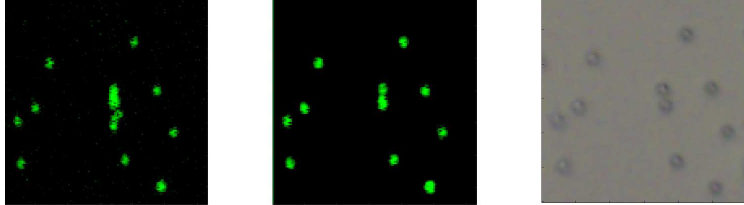
Figure 6. Imaging of the cross-section with 2 µ m microspheres only: ( Left ) SOCT image of the cross-section obtained by short-time Fourier transform method; ( Middle ) SOCT image of the cross-section obtained by the proposed method; and ( Right ) cross-sectional view of the area under investigation. SOCT images are normalized and displayed in logarithmic scale.